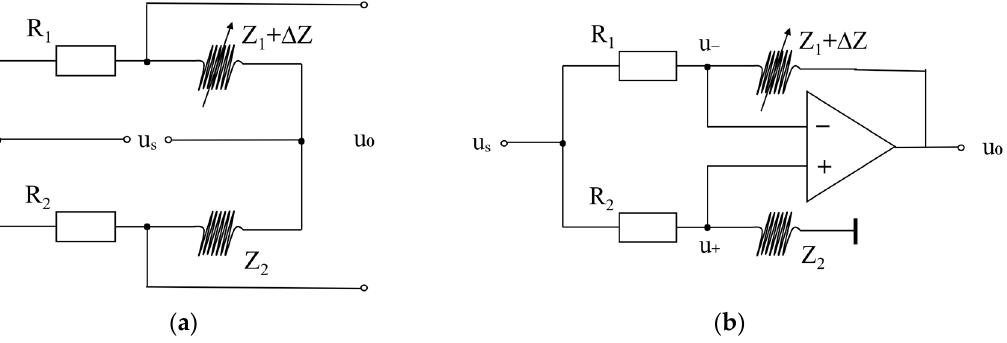
Figure 5. Circuit Simplification: ( a ) Bridge circuit; ( b ) Bridge nonlinear correction circuit.